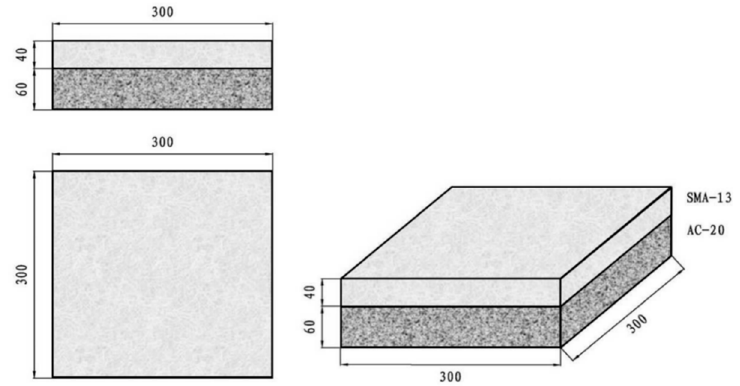
Figure 3. The size of the mold for the wheel tracking test specimen (mm).